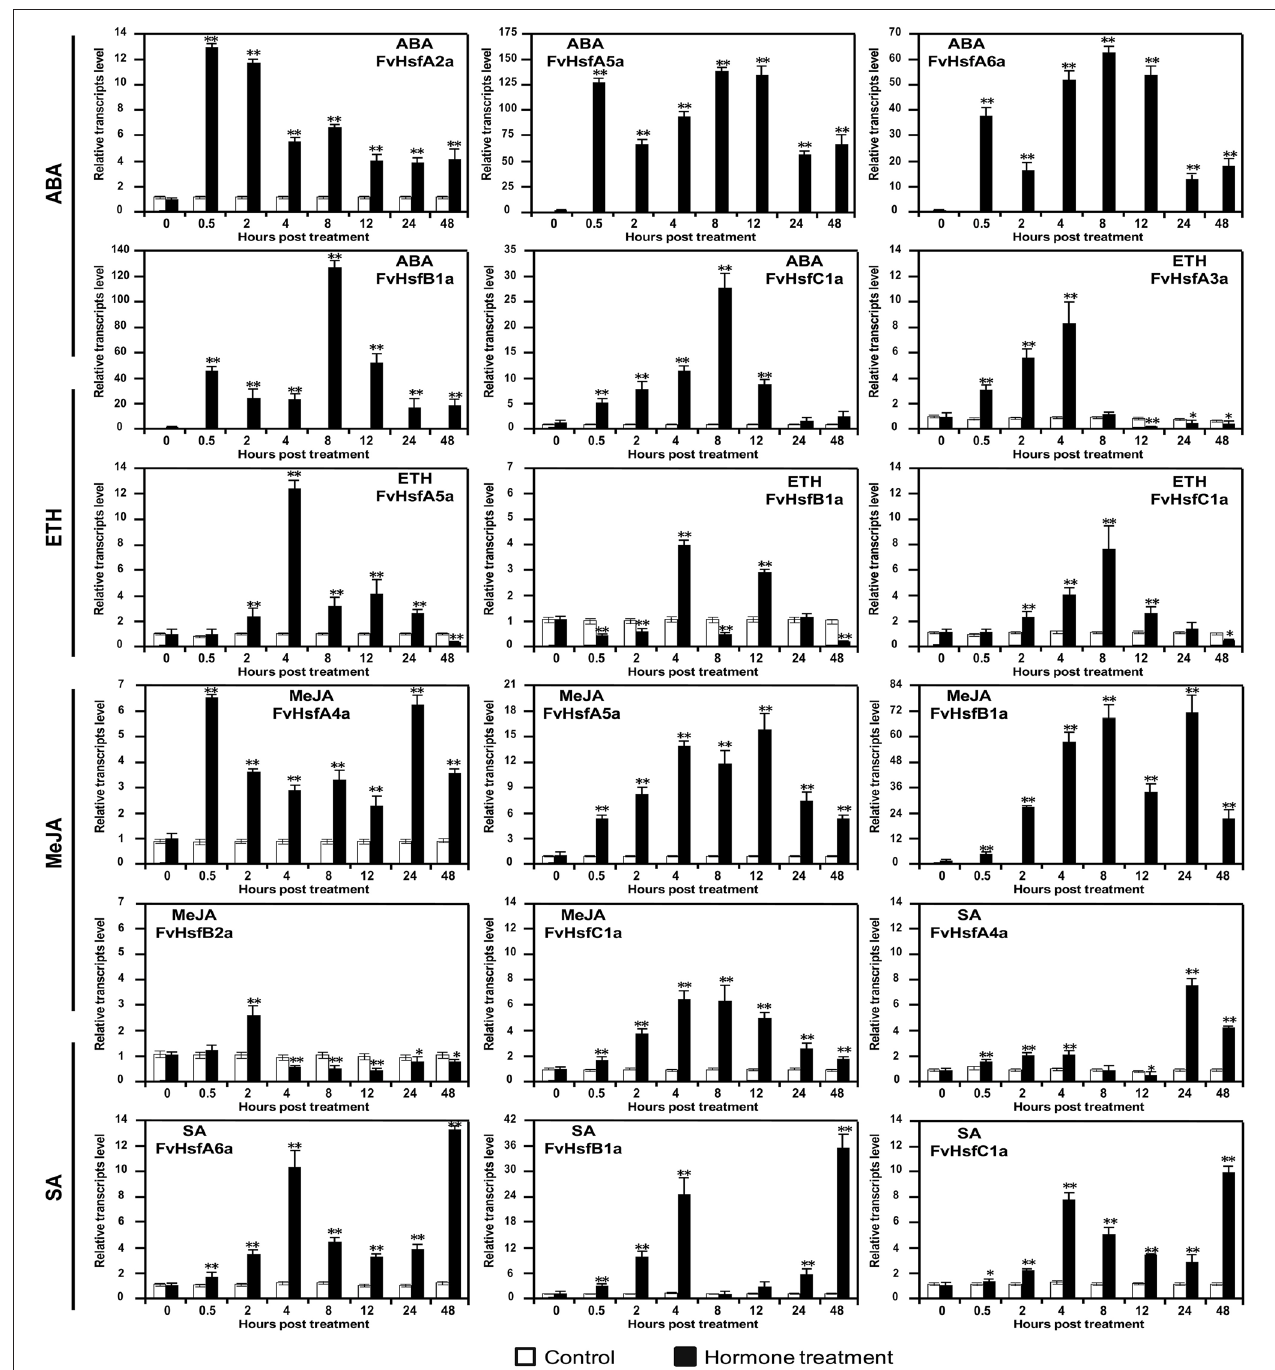
FIGURE 8 | The expression of Hsf genes in the diploid woodland strawberry ( F. vesca ) in response to treatment with plant hormones. The expression levels of several representative FvHsf genes showed unusual patterns in response to ABA, SA, MeJA, and ethylene (Eth) treatments.